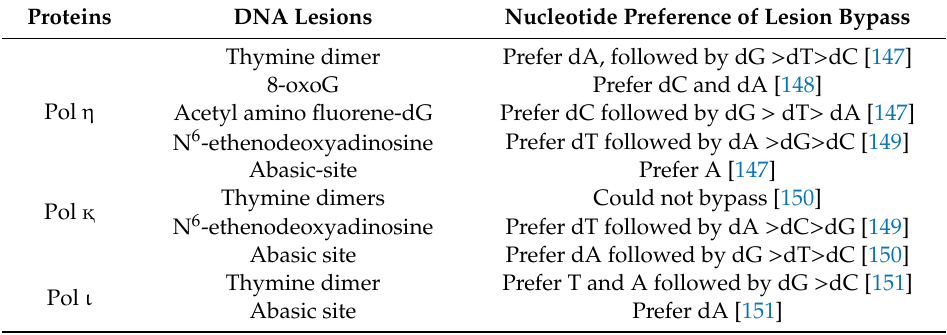
Table 2. Translesion DNA polymerases and their bypass of DNA base